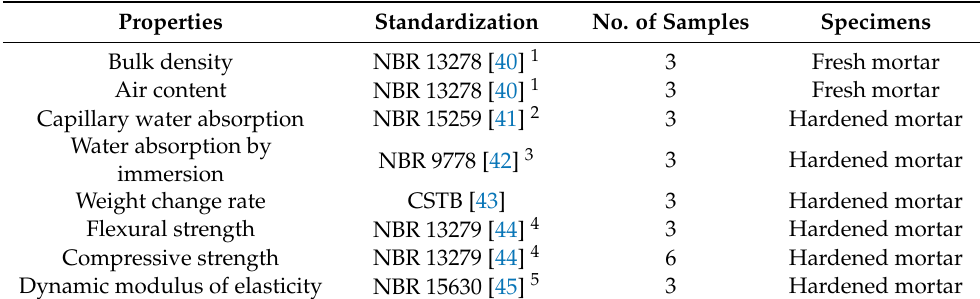
Table 4. Mix design of the